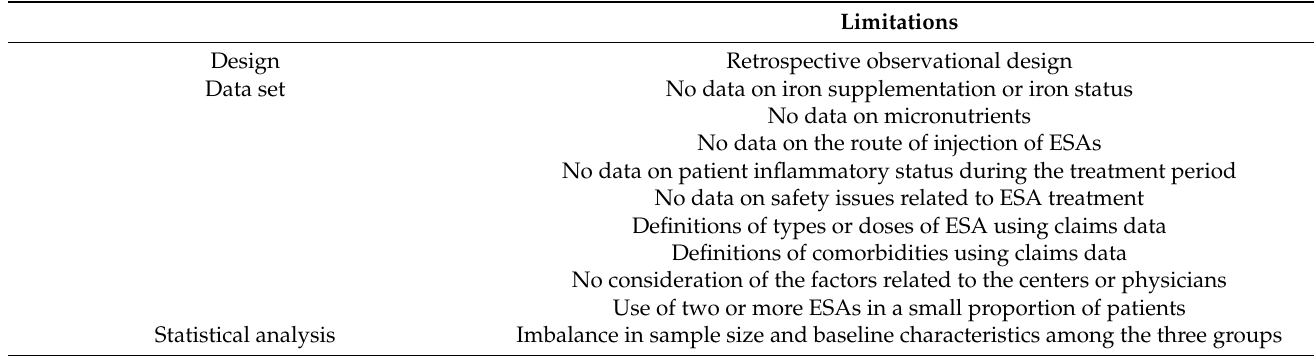
Table 3. Limitations of the study.